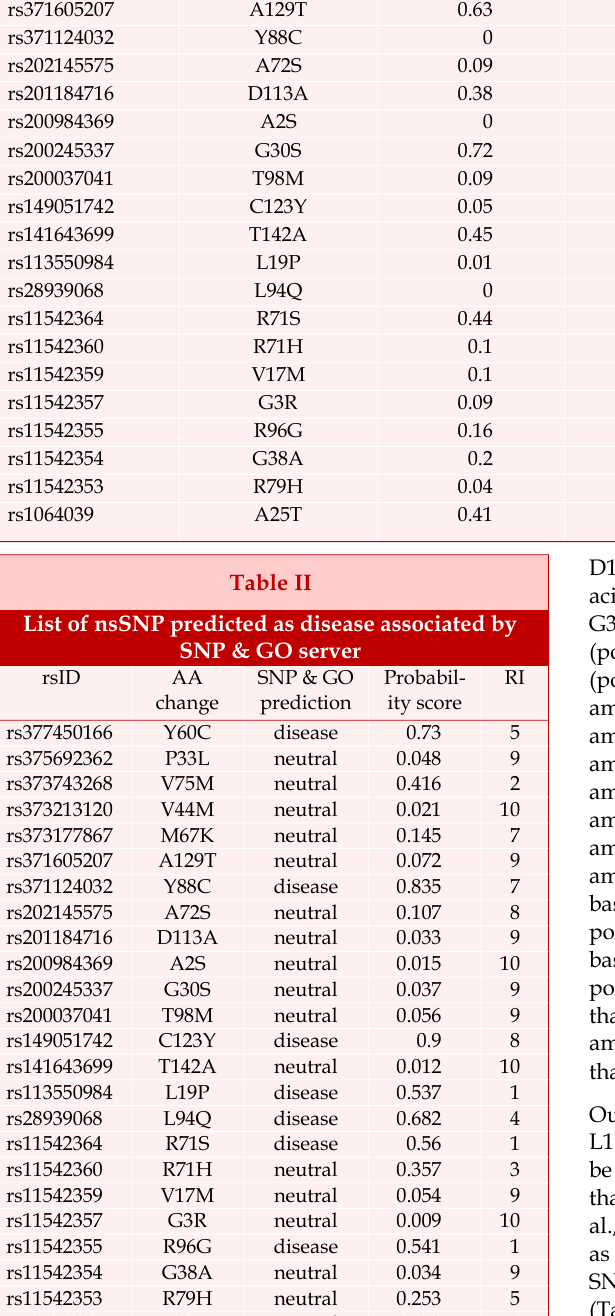
(Table III), and PANTHER predicted 11 variants as disease (Table IV). Finally combining the results of all